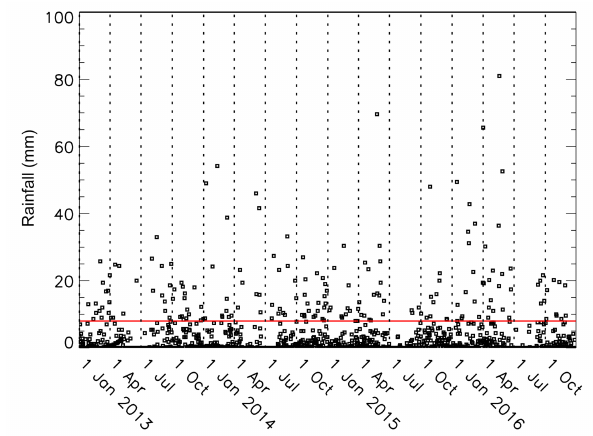
Figure 3. Daily rainfall totals for 4 years of the observational record, beginning on 1 January 2013. The red line marks the 8mm point, which is used to partition rain days between WET ( ≤ 8mm) and VWET( > 8mm).